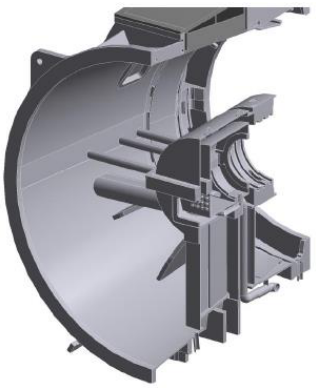
Fig. 1. Exhaust hood 3D